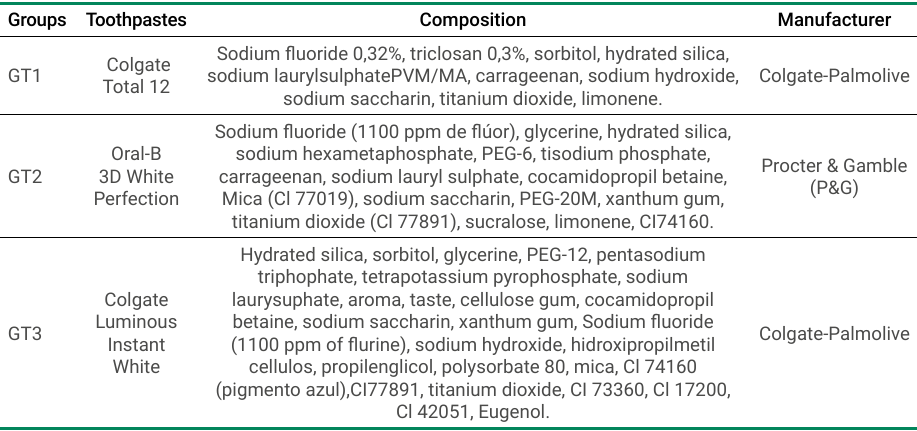
Table 1. Description of the test groups with the toothpastes. Groups